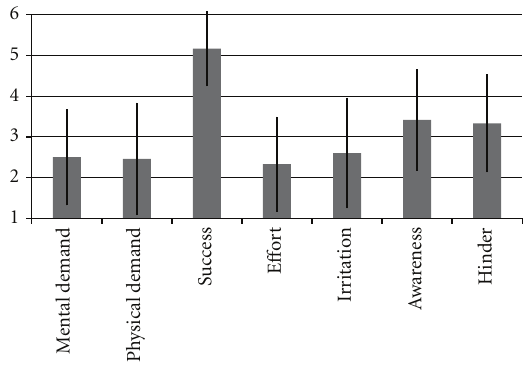
Figure 4: NASA Task Load Index. Average of all